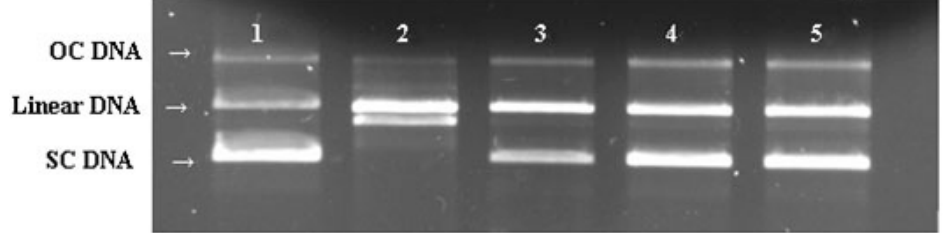
Figure 7. Protective effect of the exopolysaccharide on plasmide DNA breaks by OH generated from a Fenton reaction: (lane 1) DNA incubated without Fenton reactant; (lane 2) DNA incubated with Fenton reactant; (lane 3–5) DNA incubated with Fenton reactant and the EPS at 0.667, 1.167 and1.667 mg/mL, respectively.